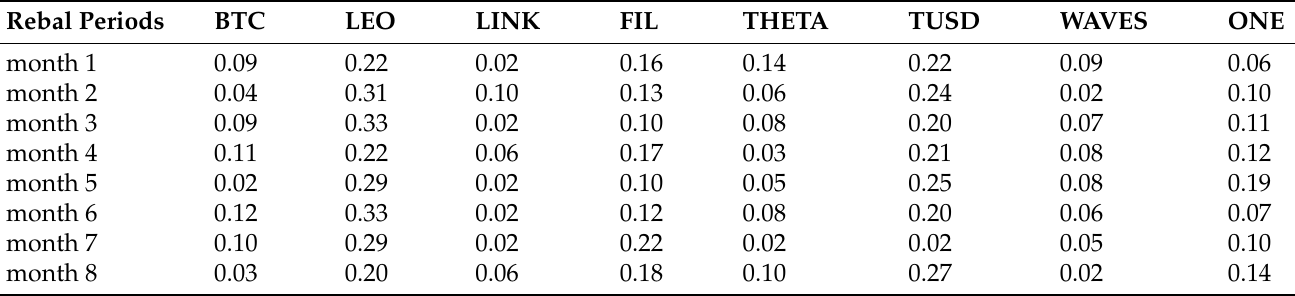
Table 11. Cvine: weighs.